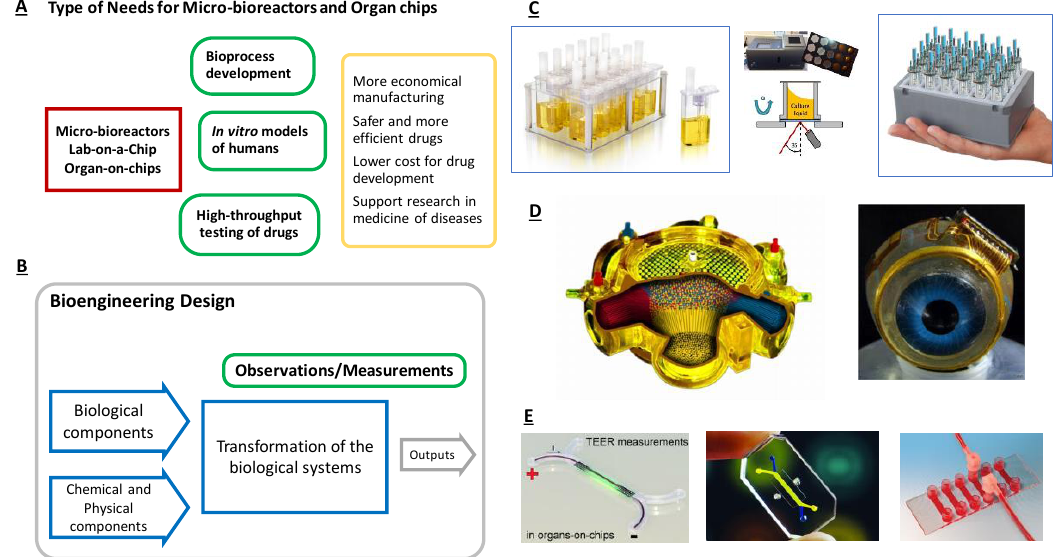
Figure 1. The similarities and diversities of micro-bioreactor design. ( A ) MBRs and OoCs have distinct purposes, which are expressed as user needs and requirements, e.g., the device should generate data for more economical manufacturing, safer and more efficient drugs, low cost for development, and support for medical research; ( B ) Despite the diversity in needs, a common transformation process can be outlined; ( C ) This is shared for MBRs used for process development; ( D ) for artificial liver bioreactors; and ( E ) for small plastic chips with multi-channels and internal membranes.